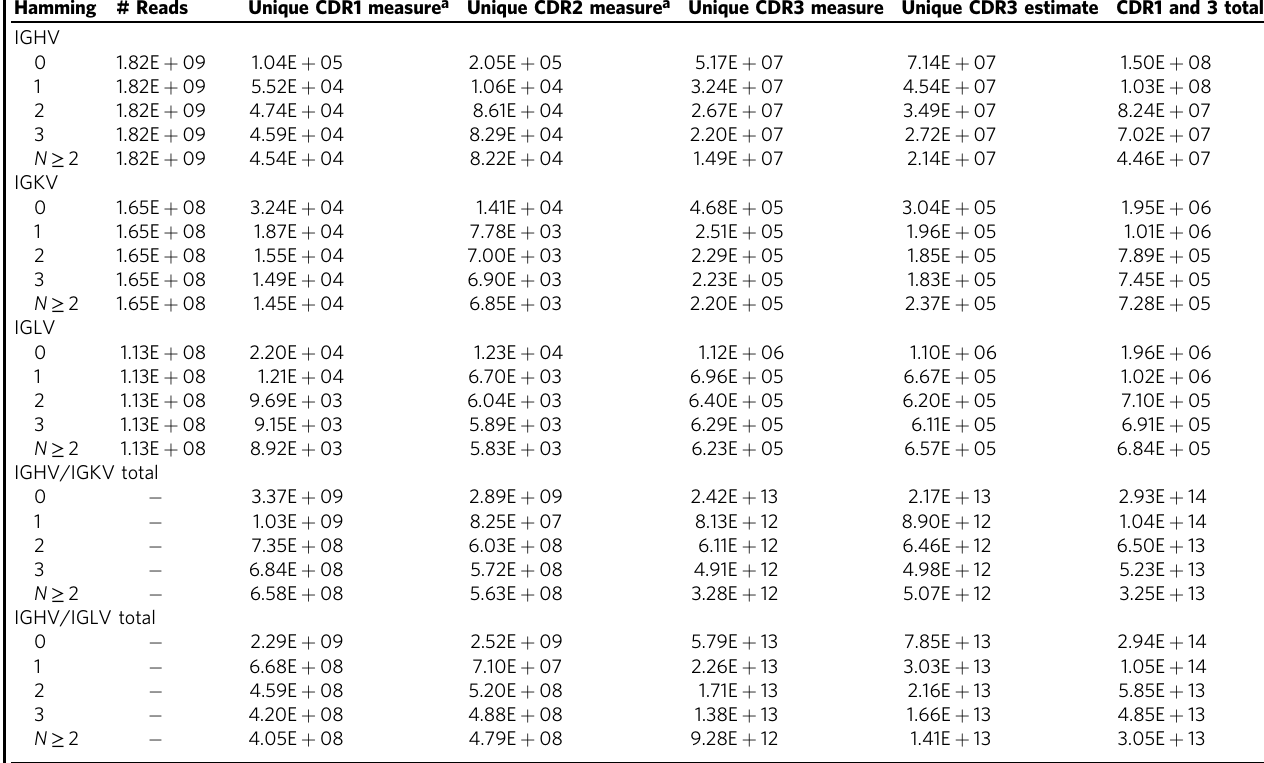
Table 3 Diversity of the variable regions measured at varying hamming distances. Hamming #